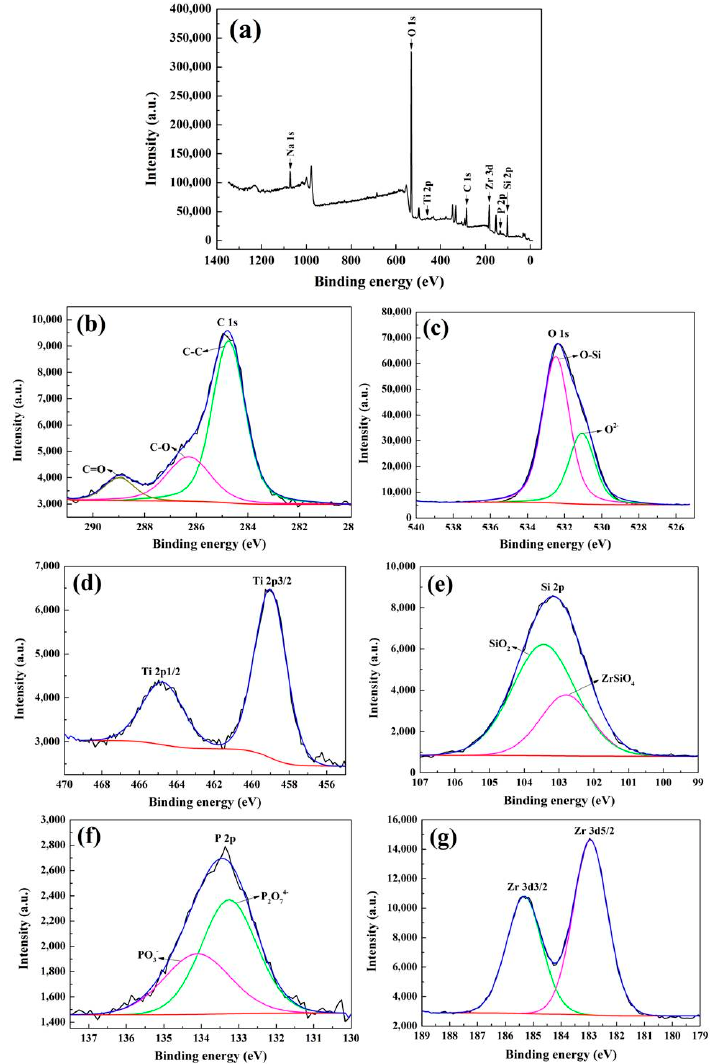
Figure 5. X-ray photoelectron spectroscopy (XPS) spectra of MAO coatings prepared with K 2 ZrF 6 concentrations of 6 g/L: ( a ) Survey; ( b ) C 1s; ( c ) O 1s; ( d ) Ti 2p; ( e ) Si 2p; ( f ) P 2p; ( g ) Zr 3d.